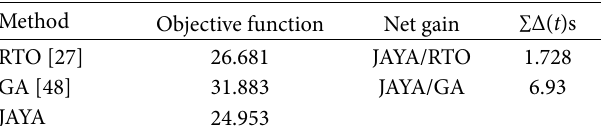
Table 10: Comparison of the total net gain time achieved by the proposed method for Case 2.